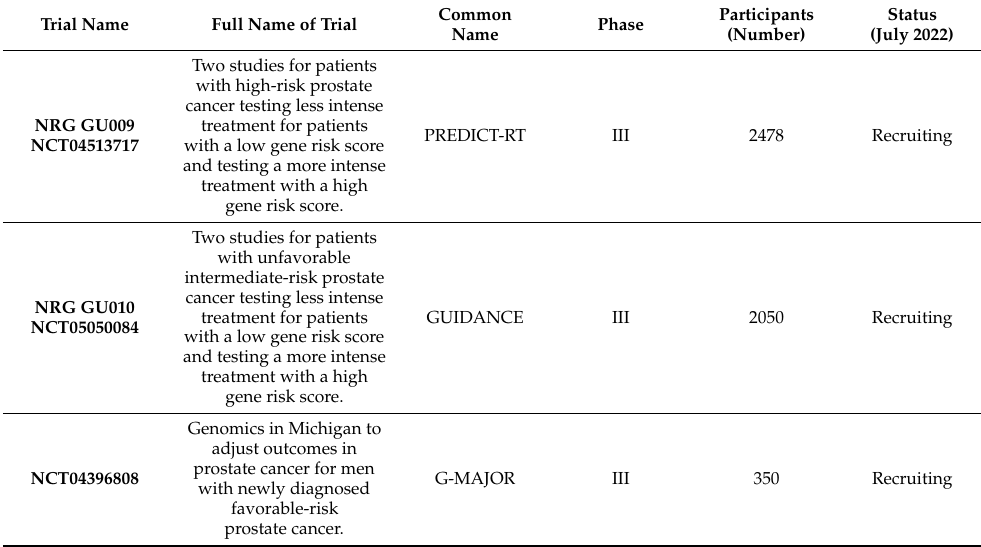
Table 3. Selected ongoing trials evaluating genomic biomarkers to guide treatment decisions in patients undergoing definitive radiation